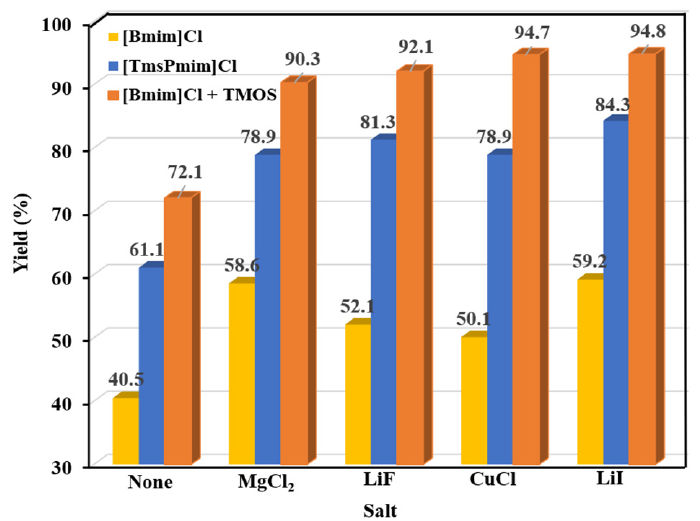
Figure 1. Effect of salt on the productivity of ethylene methoxycarbonylation with CO 2 as CO sur- rogate. Reaction conditions: Ru 3 (CO) 12 (0.010 mmol), Salt (0.126 mmol), Methanol 5.6 mL, Ethylene 0.2 MPa, CO 2 4.0 MPa, 200 °C, 4 h. ( ) [Bmim]Cl (5.6 mmol); ( ) [TmsPmim]Cl (5.6 mmol); ( ) [Bmim]Cl (5.6 mmol) and TMOS (4.2 mmol).